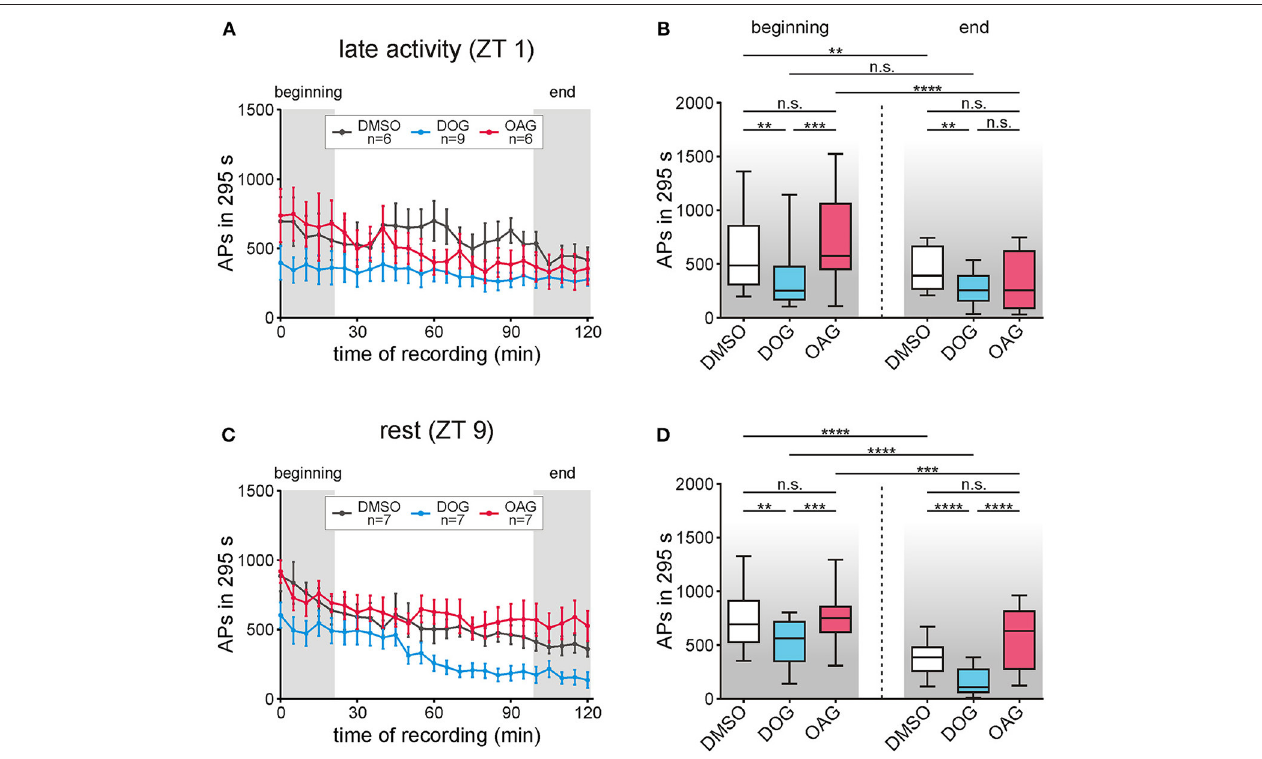
FIGURE 8 | Only the diacylglycerol-analog DOG but not OAG decreased the late, long-lasting pheromone response (LLPR) at both Zeitgebertimes (ZTs). The number of APs between 5s and 300s after each stimulation with 1 µ g bombykal was evaluated and statistical analysis was performed for the first and last 20min of the recordings (gray areas, A,C) . (A,B) During the late activity phase the LLPR decreased in controls ( n = 6) and during application of 100 µ M OAG ( n = 6) but no significant differences were found when comparing both groups. However, 100 µ M DOG ( n = 9) highly significantly decreased the LLPR in comparison to the controls but showed no changes over the course of time. (C,D) In recordings during rest the LLPR continuously decreased in controls ( n = 7) as well as with DOG ( n = 7) or OAG ( n = 7). Again, application of OAG did not change the LLPR in comparison to the controls while with DOG a significant reduction and steady decline occurred in the first and the last 20min of the recordings (for exact P -values see Table 5 ; for mean values ± SEM see S7. n.s. = not significant; * P < 0.05; ** P < 0.01; *** P < 0.001; **** P < 0.0001; Wilcoxon test, Mann-Whitney test or Kruskal-Wallis test with Dunn’s post-hoc test for multiple